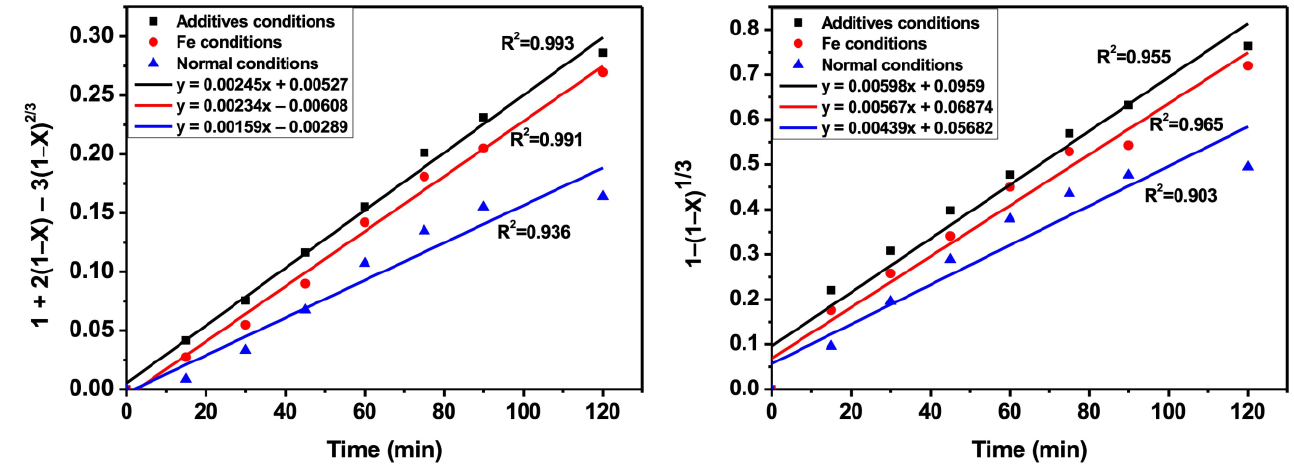
2 3 vs. time ( left ) and 1 − (1 − x)